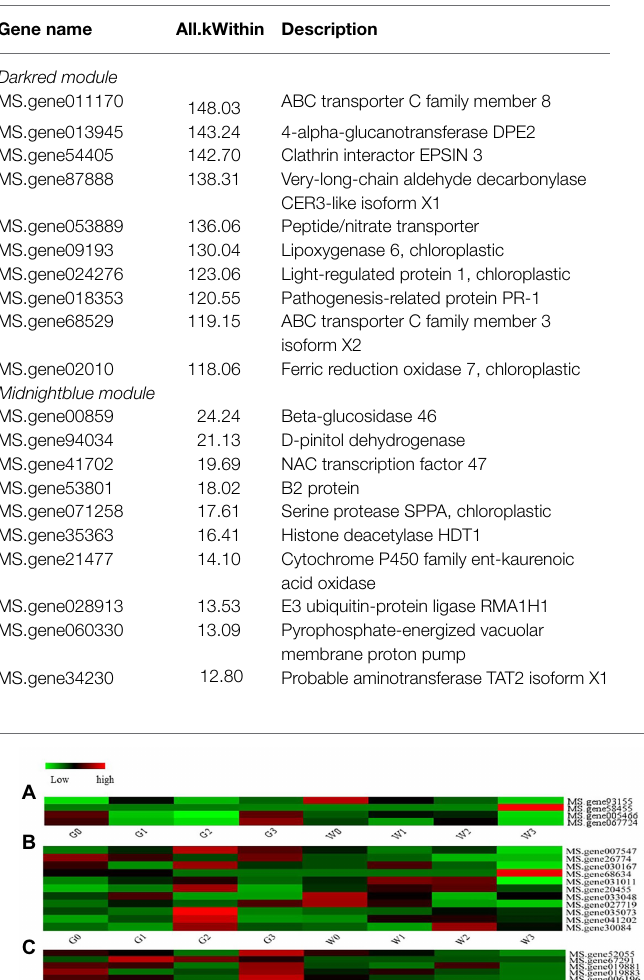
TABLE 1 | The details of 10 hub genes from the two key